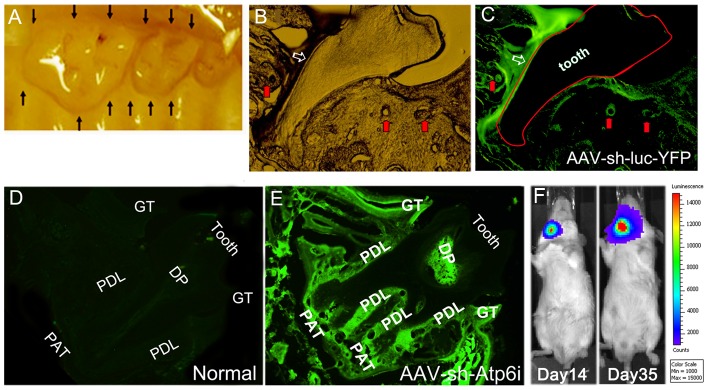
AAV effectively transduced periodontal tissue and displayed a local distribution pattern in vivo.(A) Mouse maxillary molars showing sites of AAV injection sites (black arrows). (B, C) The light microscope image (B) and fluorescence microscope image (C) reveal YFP expression after local injection with AAV-sh-luc-YFP. (D, E) Compared to normal mouse tissues that did not receive AAV treatment (D), local injection with AAV-sh-Atp6i resulted in EGFP expression (E) in gingival tissue (GT), periodontal ligament (PDL), dental pulp (DP), periapical tissue (PAT), and alveolar bone adjacent to PDL. (F) Image analysis 14 or 35 days after local injection of AAV-Luc into the mouse lower right jaw; luciferase expression was sustained and limited to the local injection site. (n = 5 for each time point, each time point was repeated 3 times).